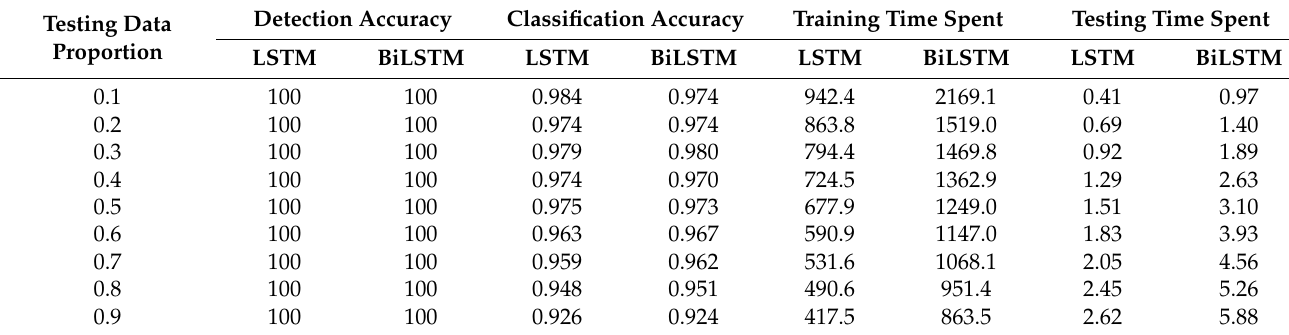
Table 6. The results comparison of LSTM with